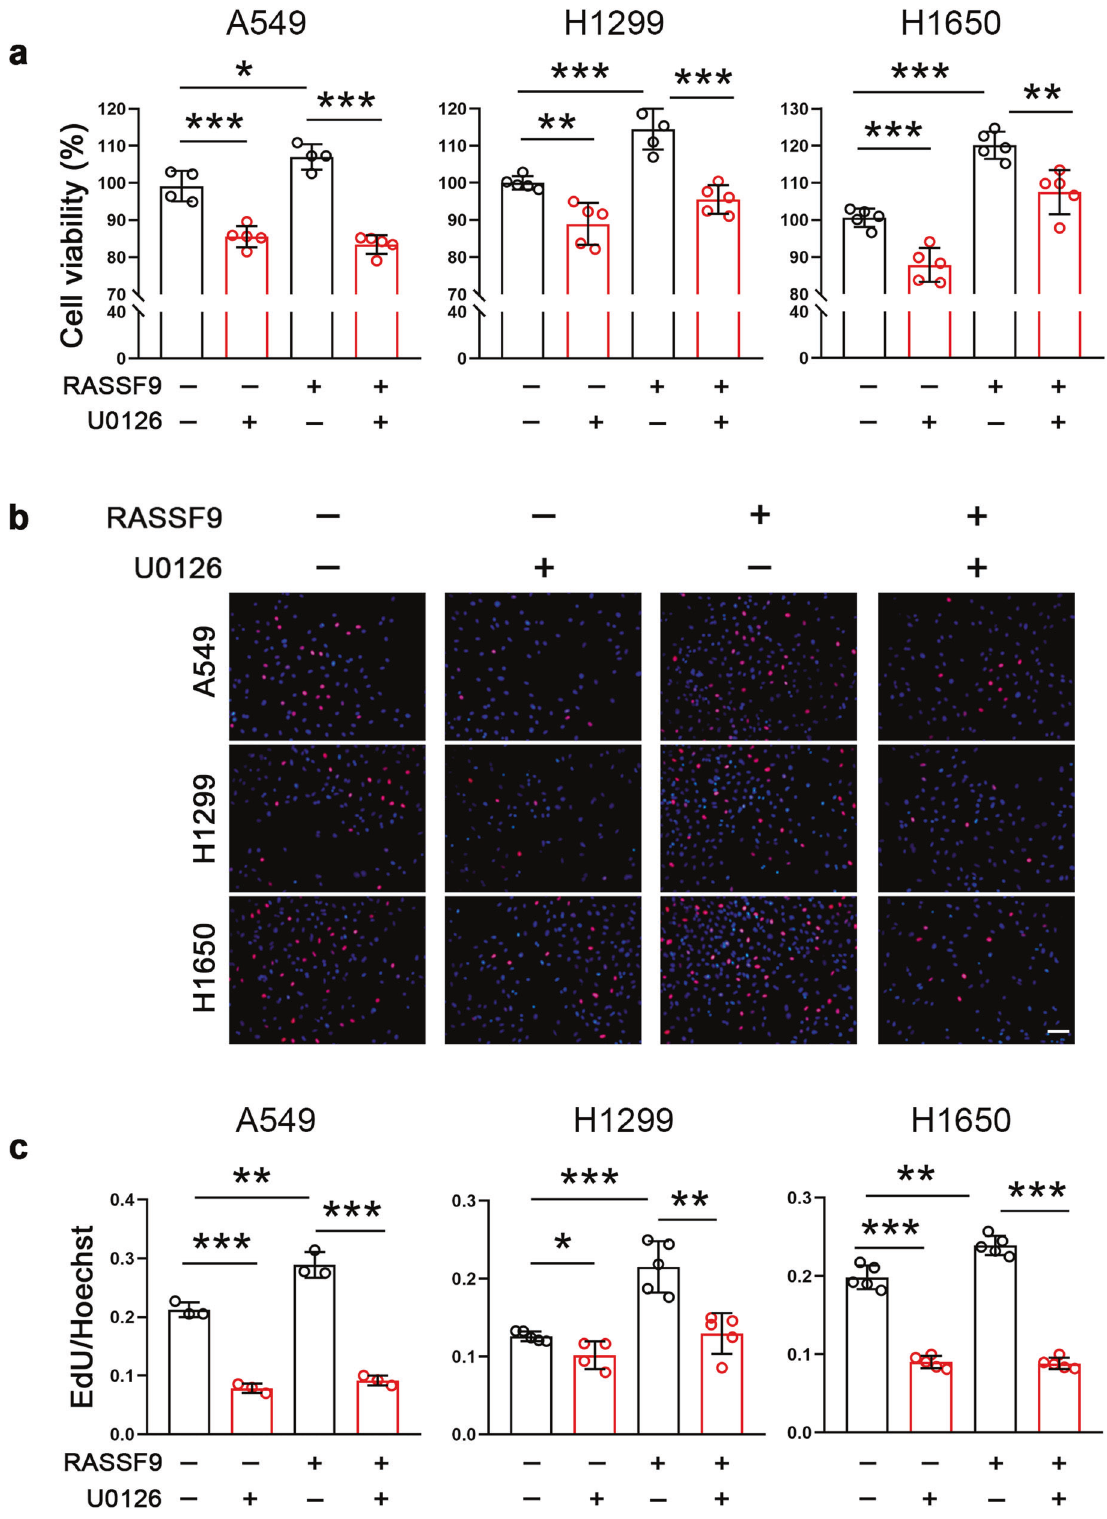
Fig. 6 MEK inhibition by U0126 abolishes RASSF9-induced NSCLC cell viability and proliferation. a U0126 reduces the increased cell viability induced by RASSF9. A549, H1299, and H1650 cells were transfected with the plasmid expressing Rassf9 . Twelve hours post- transfection, cells were treated with 10 μ M of U0126 for additional 24 h and then subjected for cell viability assay by the method of MTT. b U0126 decreases RASSF9-induced EdU incorporation. Cell treatments were described in ( a ). Scale bar = 500 μ m. c Quantitative analysis of EdU incorporation. Data are presented as means ± SD (error bars). * P < 0.05, ** P < 0.01, and *** P < 0.001. One-way ANOVA test.